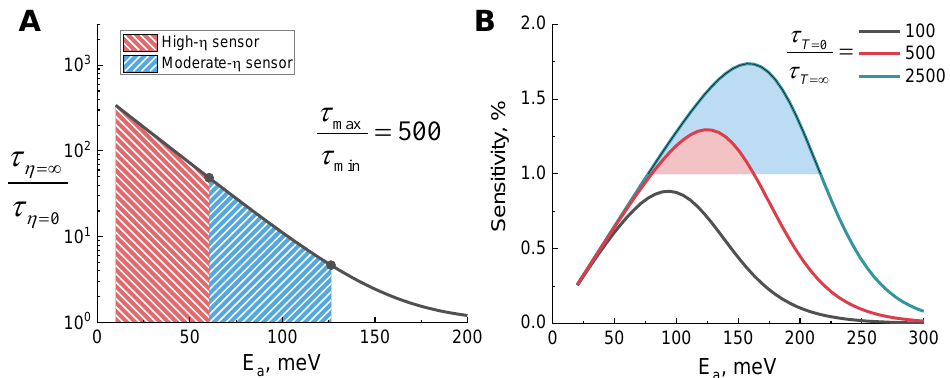
Figure 7. ( A ) Dynamic range of a viscosity sensor, expressed as a ratio of fluorescence lifetimes at zero and infinite viscosities, with respect to the energy barrier height for non-radiative viscosity-dependent relaxation. τ max / τ min was set to 500 and T was set to 298 K. The shaded areas correspond to energy barrier values that would be appropriate for a moderate-viscosity sensor and a sensor suitable for high viscosities only. ( B ) Sensitivity to the temperature of the fluorescent temperature sensor with respect to the height of the energy barrier for non-radiative relaxation, which is temperature-dependent. The curves were calculated for three different τ T = 0 / τ T = ∞ ratios: 100 (black), 500 (red), and 2500 (blue). The shaded areas correspond to energy barrier values resulting in sensitivity above